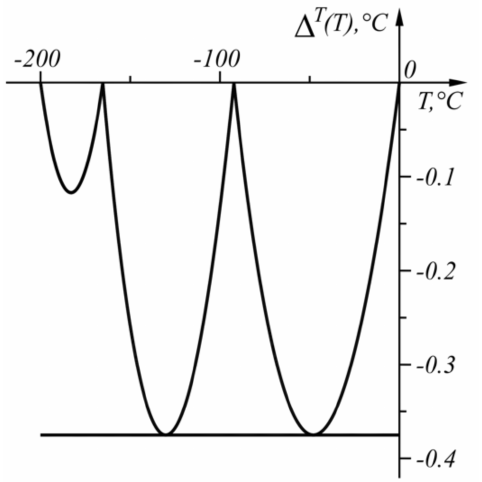
Figure 11. Graph of the function ∆ T ( T ) in the range T ∈ [ − 200, 0 ] ◦